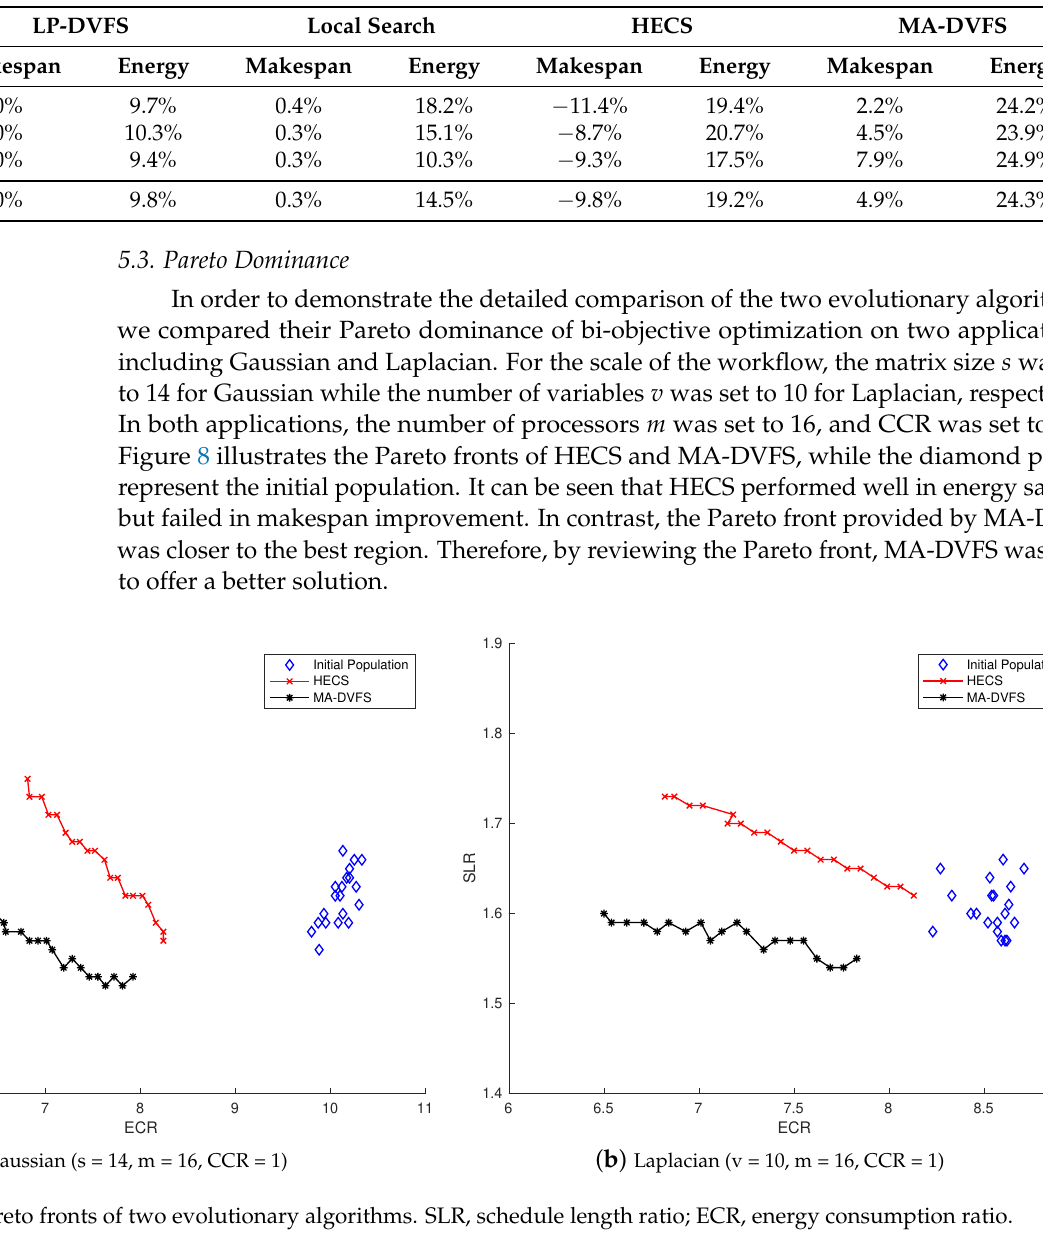
Table 4. Performance comparison of four scheduling algorithms. LP, linear-programming.